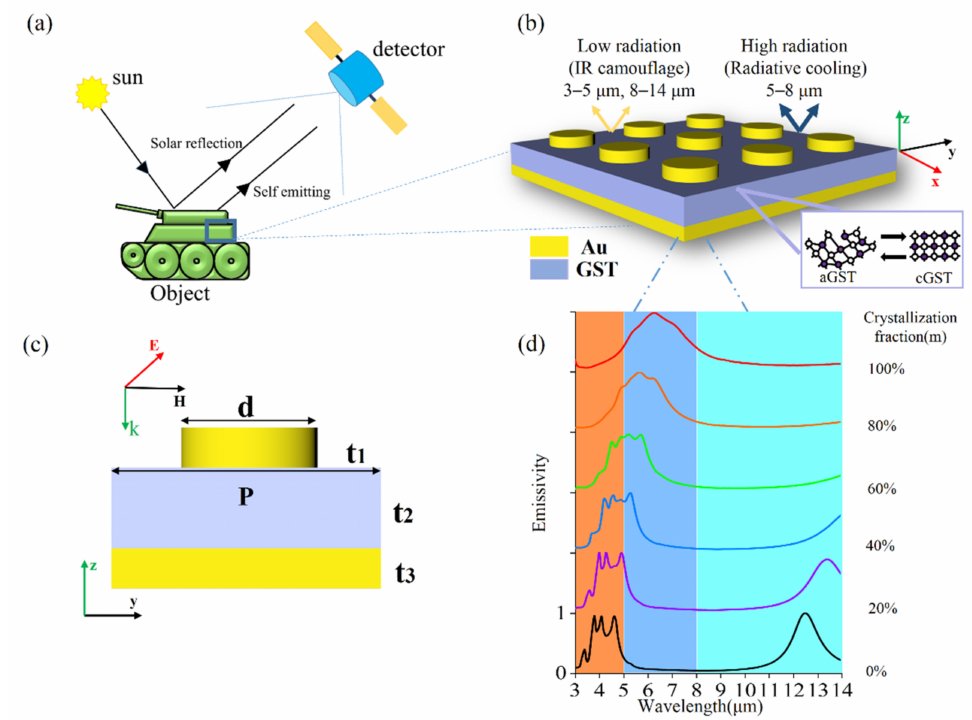
Figure 1. ( a ) Schematic of the IR detection process and a typical application for a tank requiring thermal camouflage; ( b ) Schematic and ( c ) sectional view of the proposed ultrathin MIM plasmonic thermal emitter based-on phase-change material GST. The MIM thermal emitter consists of the top gold nanodisks, the intermediate GST layer and the bottom gold layer; ( d ) The simulated spectral emissivity of the plasmonic thermal emitter gradually changes as crystallization fraction of GST increases from 0% to